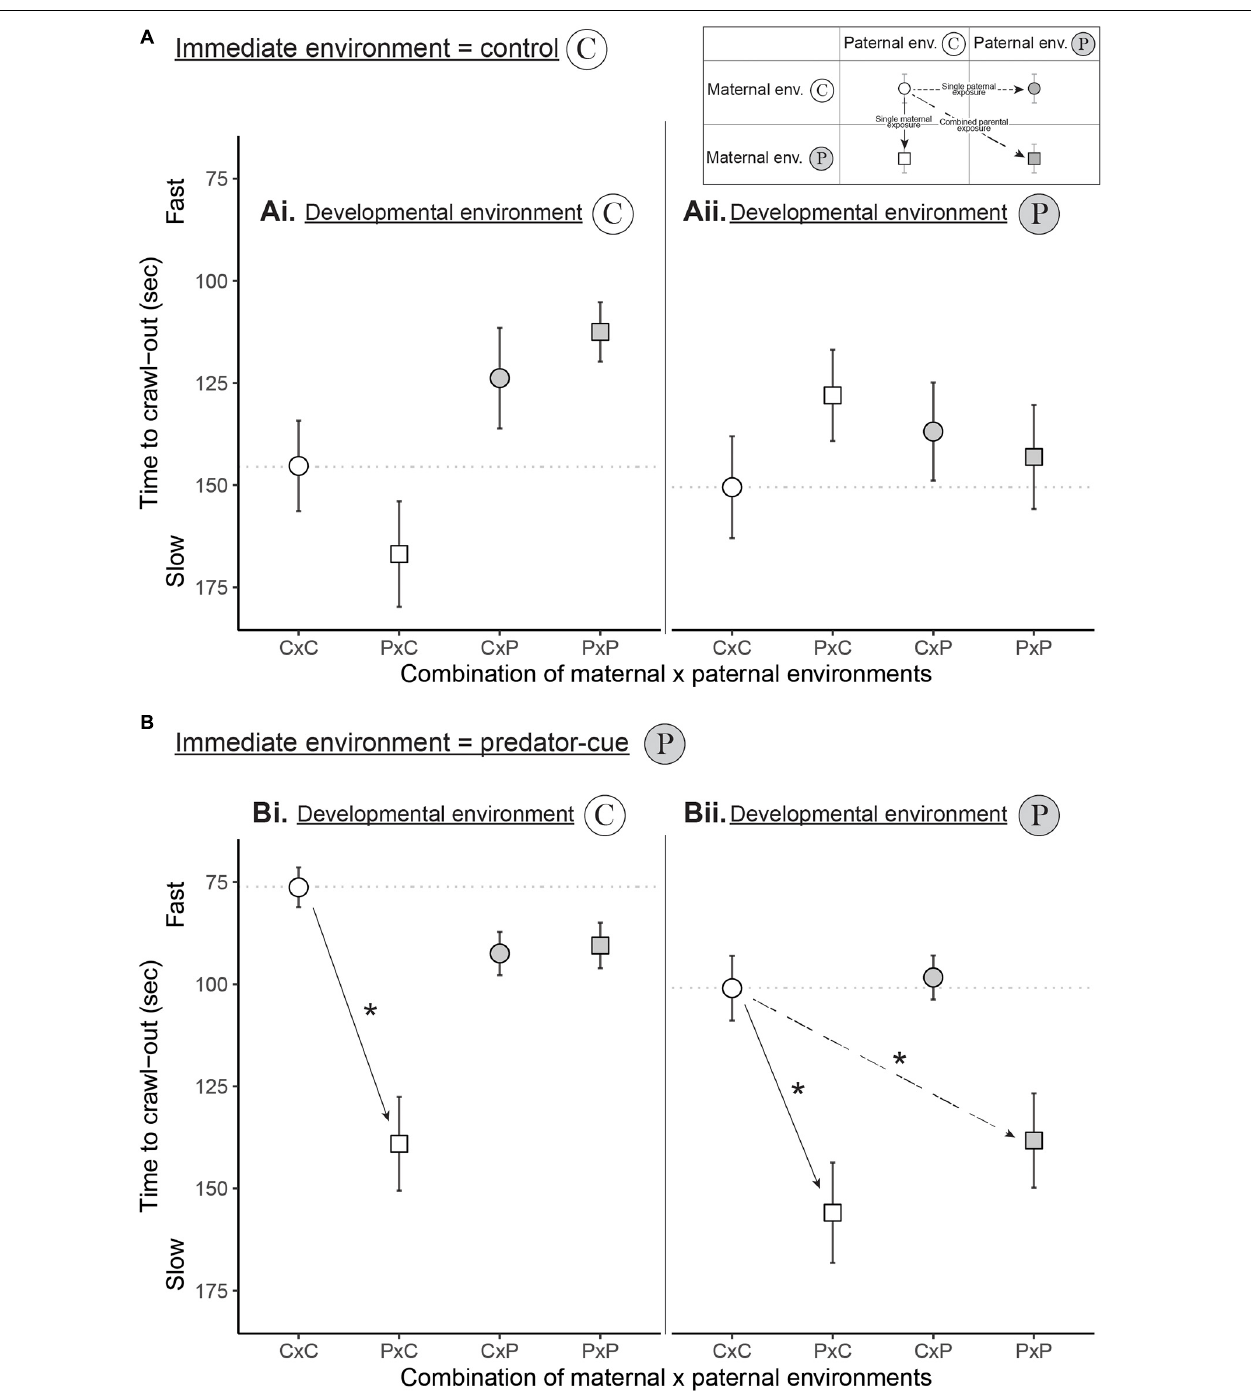
FIGURE 2 | How maternal, paternal, and developmental exposures to predator cues influenced escape behavior (time to crawl-out the water in seconds) in the (A) control and (B) predator-cue immediate environments. “C” stands for control environment and “P” stands for predator-cue environment. On each graph, the “C” developmental environment is shown on the left panel (Ai, Bi) and the “P” development environment is shown on the right panel (Aii, Bii). The x -axis represents the four combinations of maternal x paternal environments (CxC, PxC, CxP, and PxP). The horizontal dotted line is located at the mean of CxC to facilitate the comparisons with PxC, CxP, and PxP (see Appendix 2 for post hoc comparisons). Dots are for snails from non-exposed mothers while squares are for snails from exposed mothers. White shapes are for snails from non-exposed fathers while gray shapes are for snails from exposed fathers. To see the effect of single maternal exposure, single paternal exposure or combined parental exposures, follow the legend on the top right corner. Black arrows indicate a significant effect ( Appendix 2 ). Points are mean ± SE.